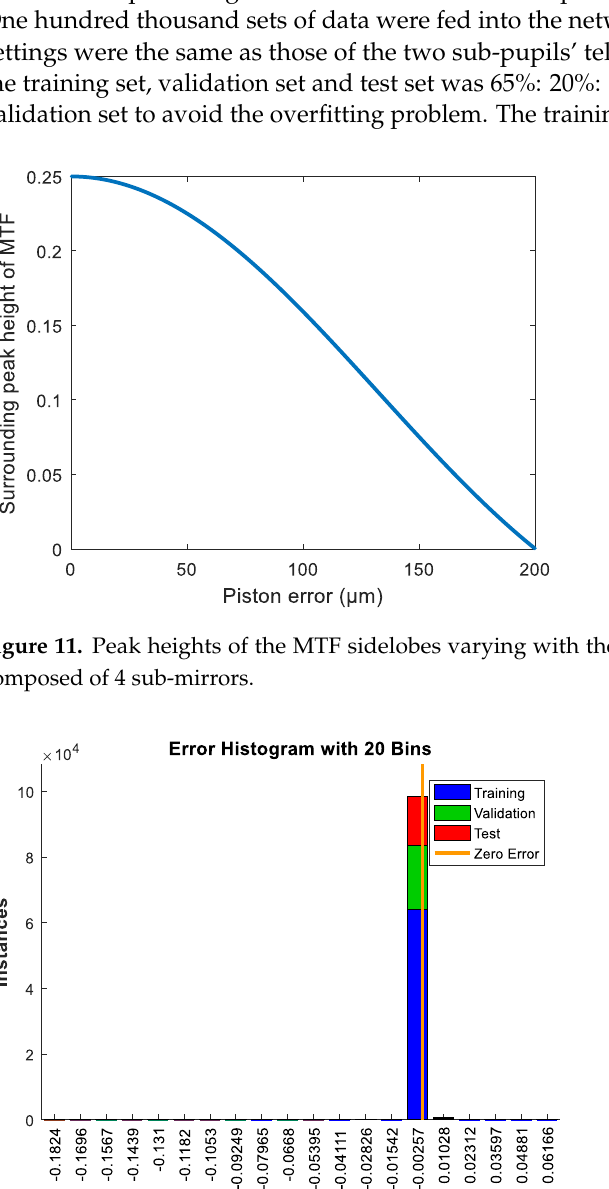
network, the piston errors of all the sub-mirrors could be measured by one CCD image at one time. A part of the simulation results is listed in Figure 13. The piston error measure- ment results of No. 2, No. 3 and No.4 sub-mirrors are given by Figure 13a–c, respectively. Figure 13d shows the total RMSE of the three sub-mirrors’ piston error measurement ac- curacy during each test. From the simulation results we can see that the multi-piston errors between the seg- ments of the entire aperture could be simultaneously detected with high accuracy: the average value of the RMS errors over the testing samples was about 1.4 nm. Since the peak height of sub-MTF corresponding to each sub-mirror was fed into the trained network to measure the piston errors, the most important issue was to avoid the MTF sidelobes re- spectively produced by the reference sub-pupil and all of the measured sub-pupils over- lapping. For the detailed arrangement rules, refer to paper [31] to confirm the MTF side- lobe distribution was non-redundant. Finally, we tried to compare our work with Ma’s work presented in paper [32], since this also used a single broadband image to sense the piston errors between sub-pupils. Rather than establishing the theoretical relationship between the MTF sidelobes of PSF